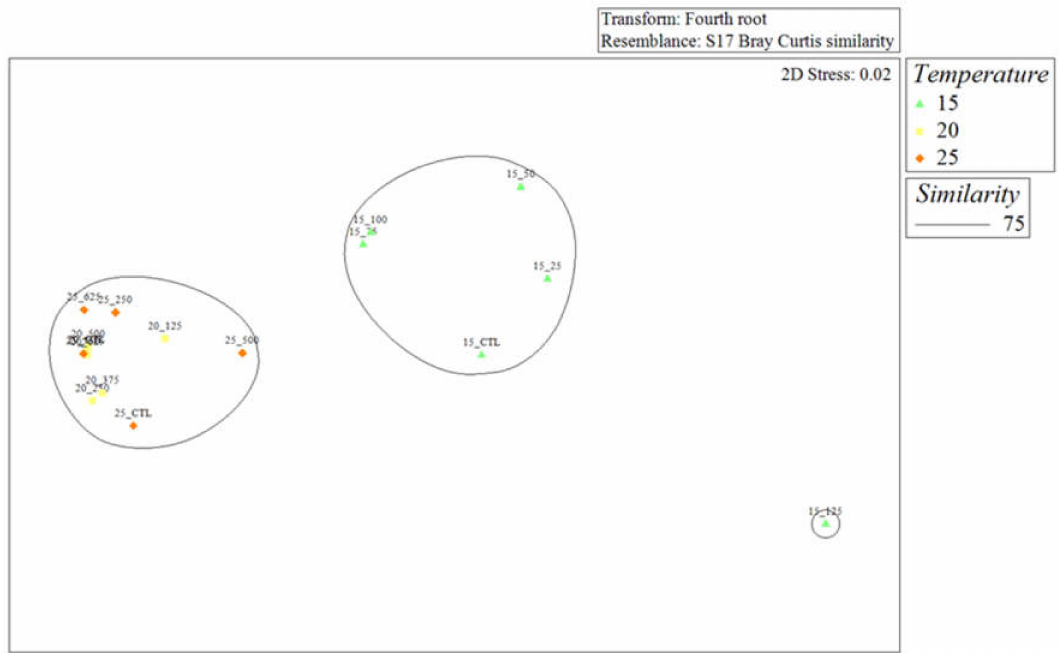
Figure 6. Two-dimensional non-metric MDS ordination plot of the FA content of the T. weissflogii exposed to copper sulfate at three temperatures (15 ◦ C, 20 ◦ C, and 25 ◦